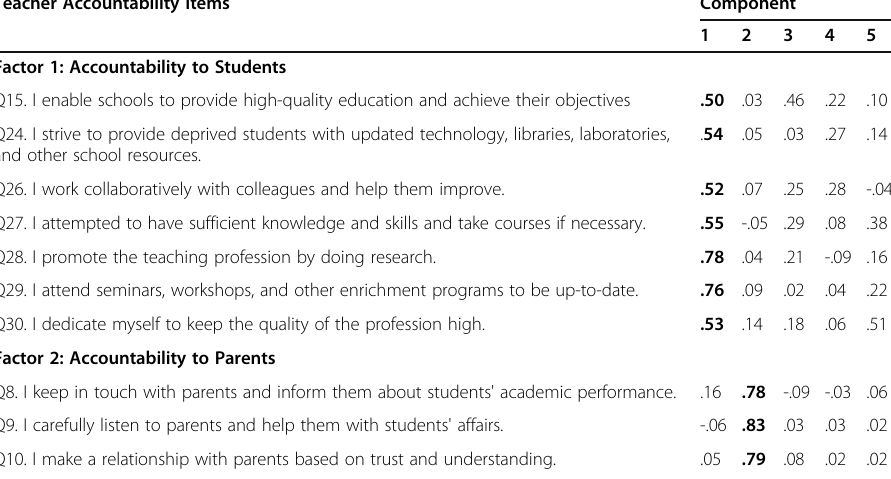
Table 4 Results from a factor analysis of the items in the Teacher Accountability Questionnaire Teacher Accountability